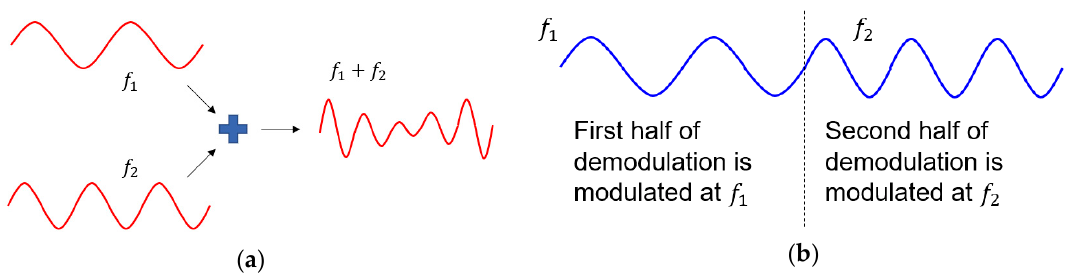
Figure 3. Schematic of simultaneous dual frequency modulation with sequential demodulation. ( a ) Superposition of two modulation frequencies to modulate the illumination source; ( b ) demodulation signal separated into two parts in sequence .